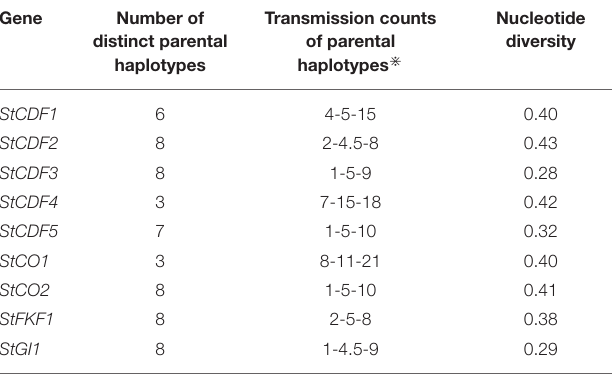
TABLE 3 | Summary of SNP phasing at the potato loci introduced in Table 1